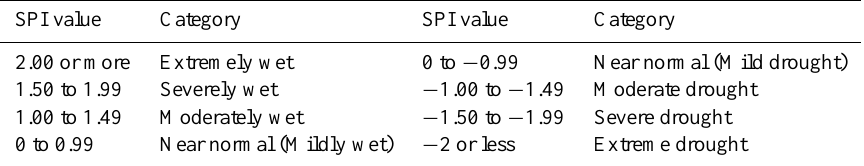
Table 3. Drought classification by SPI